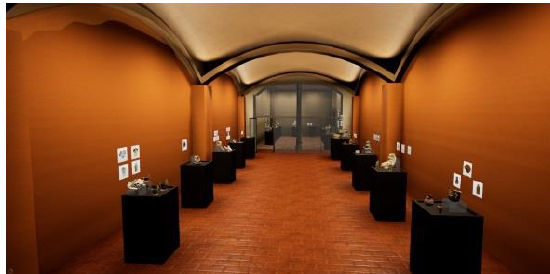
Figure 21. Screen caption of the Virtual Museum with the pieces registered with